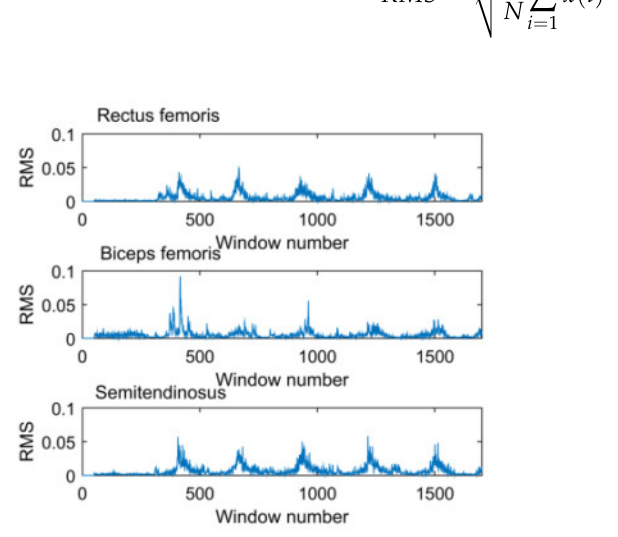
Figure 6. EMG signals in going upstairs procedure after band-pass filter.